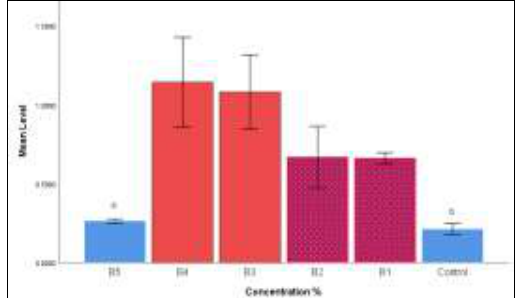
Figure 8. ANOVA diagram for different concentrations of fraction